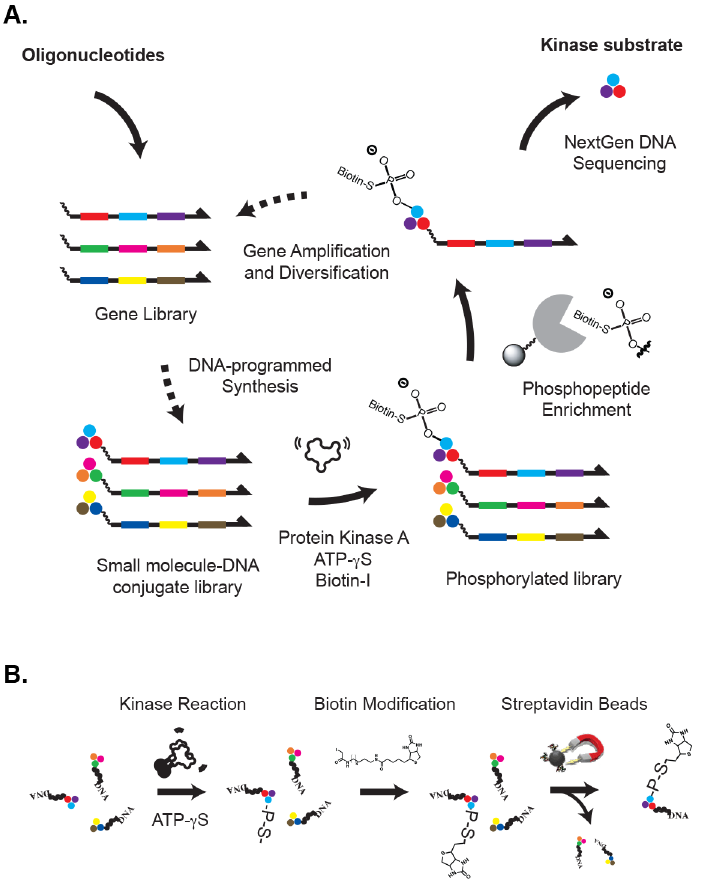
Fig 1. A. Directed evolution of kinase substrates. An initial population of DNA genes was chemically translated into peptide-DNA conjugates using a DNA-programmed combinatorial library synthesis. The library of peptide-DNA conjugate was treated with protein kinase A, and phosphorylated conjugates were isolated. The genes associated with the phosphorylated conjugates were then amplified by the polymerase chain reaction, diversified by recombination, and used to program the synthesis of a subsequent library generation. After generations 2 – 4, the gene population was sequenced. Peptides encoded by enriched genes were synthesized individually without DNA, and tested for their ability to function as protein kinase A substrates. The gene amplification, diversification and DNA-programmed library synthesis steps (dashed arrows) were required to close the evolutionary cycle. DNA-tagged library techniques utilize a linear process, consisting of an unprogrammed synthesis of small molecule-DNA conjugates, a selection for function, and DNA sequencing (e.g. solid arrows). B. Selection for kinase substrates. The peptide-DNA conjugate library was incubated with protein kinase A and ATP- γ -S. The enzymatically treated library was then alkylated with biotin iodoacetamide, which coupled a biotin moiety to thiophosphorylated peptides. The biotinylated peptide- DNA conjugates were affinity purified on paramagnetic streptavidin beads. See S1 Fig for a quantification of phosphopeptide